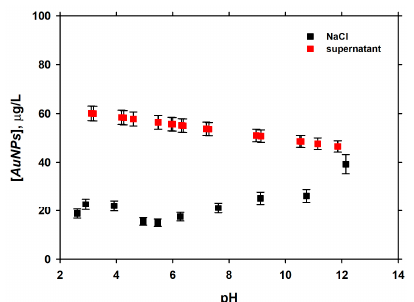
Figure 2. The concentration of AuNPs measured after 60 min in 0.01 M NaCl and in diatom supernatant obtained after reaction with 0.5 g wet /L of biomass. The initial concentration of AuNPs in both cases was 60 µ g/L. The error bars are within the symbol size unless shown. They correspond to standard deviation of